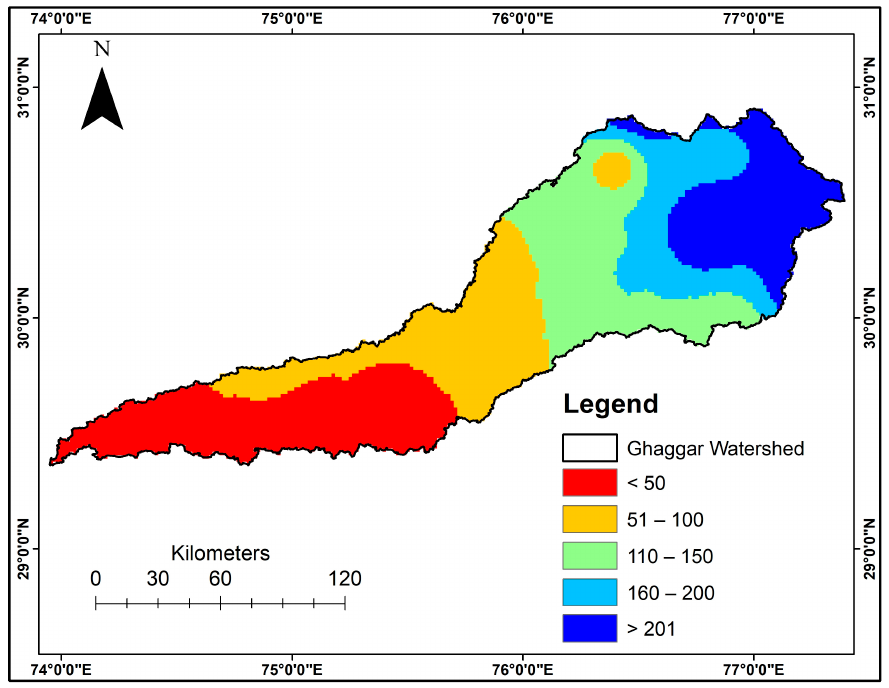
Figure 11. Average rainfall distribution in the study area (Source: chrsdata.eng.uci.edu).